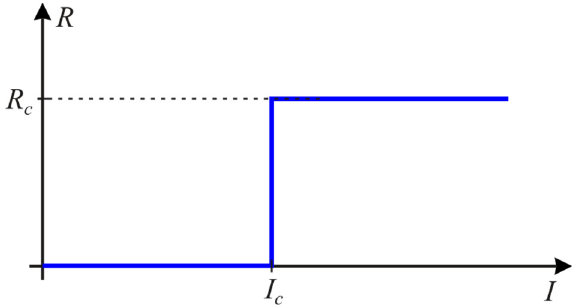
Figure 3. Simplified transition characteristics of a superconductor.